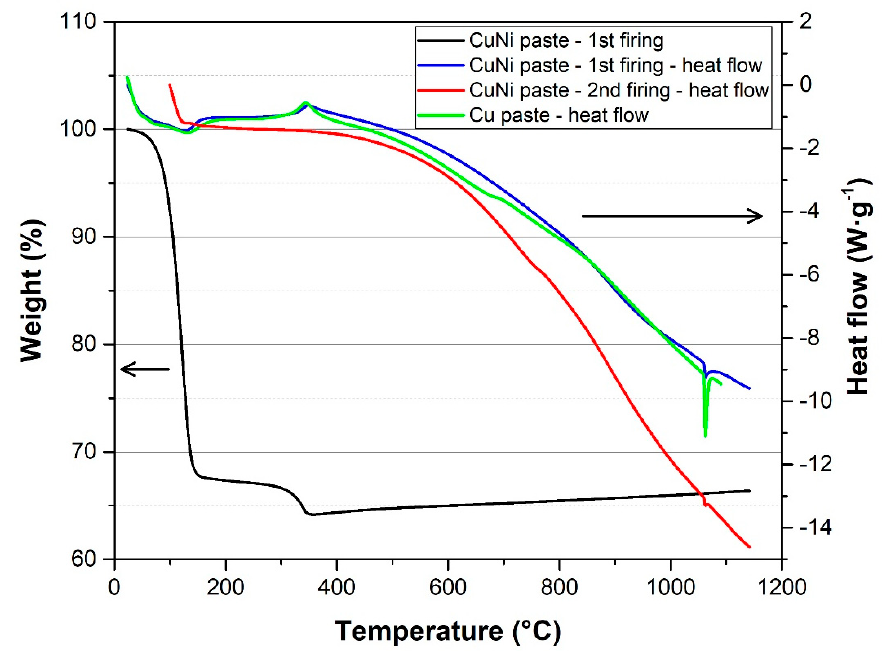
Figure 4. STA analysis of copper-nickel thick film paste (nitrogen atmosphere, 5.0 nitrogen purity).